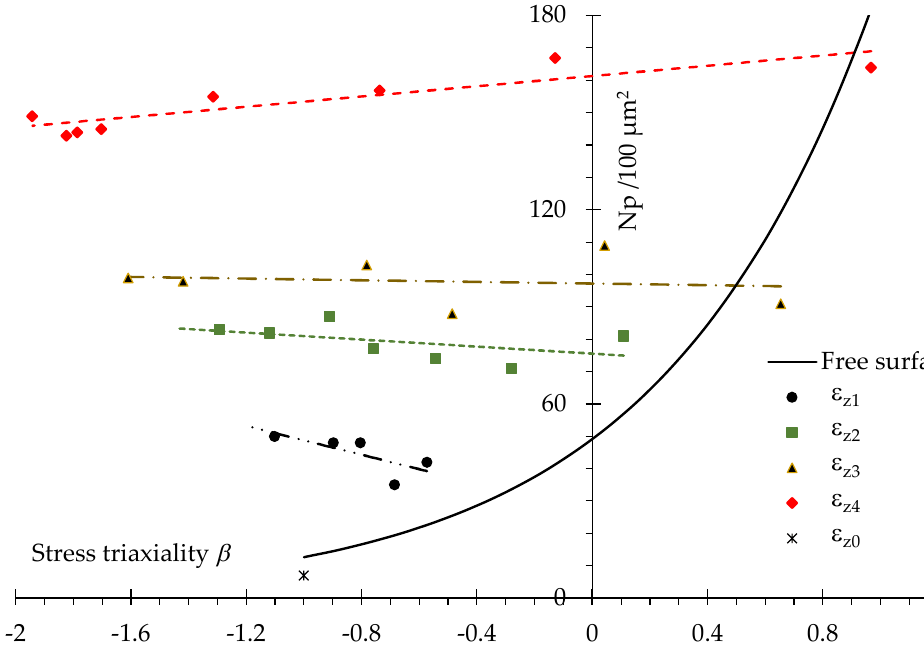
Figure 21. Density of microcracks in Zones I-IV as a function of stress triaxiality.